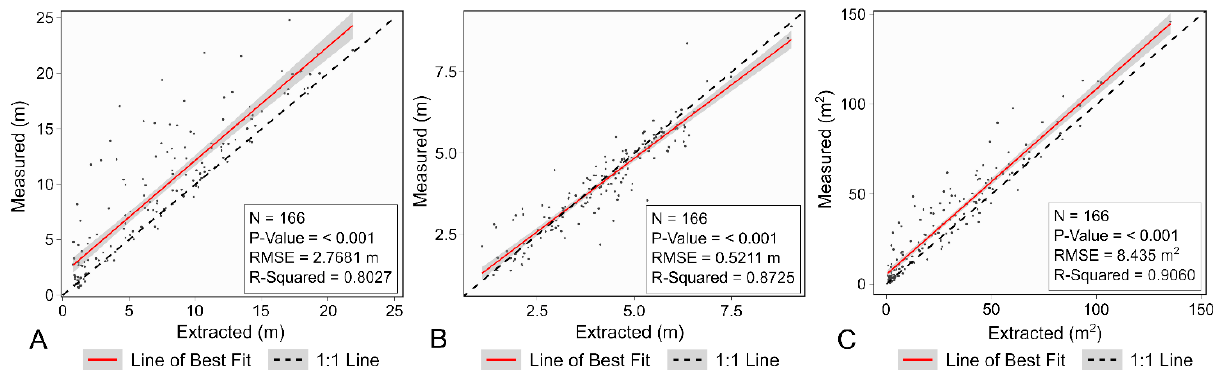
Figure 7. Agreement between measured and extracted ( A ) vertical length, ( B ) diameters, and ( C ) volume of live branch clusters. In each panel, the line of best fit is displayed in red, and the 1:1 line is shown as the dashed black line.